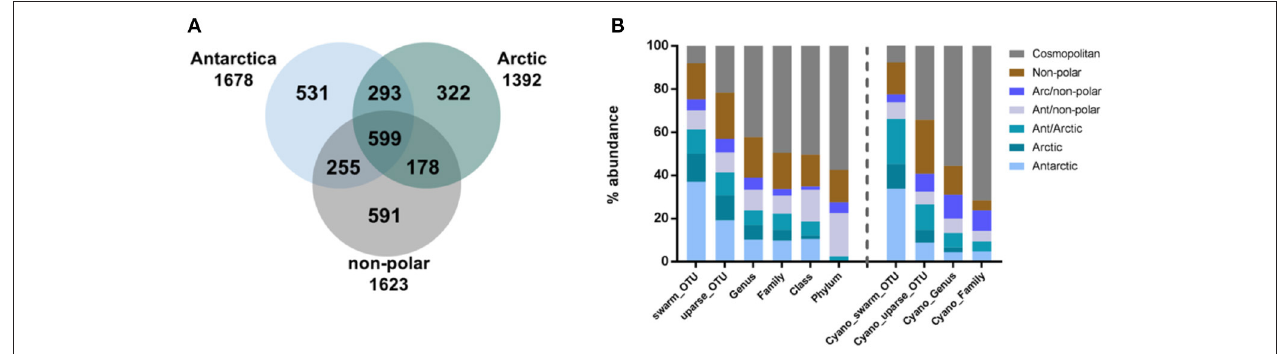
FIGURE 3 | Geographic distribution of operational taxonomic units (OTUs). Numbers of OTUs are based on the UPARSE-algorithm and rarefied to the same number of samples per region and 546,002 reads per sample. The number of shared bacterial OTUs between the three regions is displayed in (A) and the geographic distribution of bacteria (left) and cyanobacterial (right) sequences relative to their phylogenetic level in (B) .